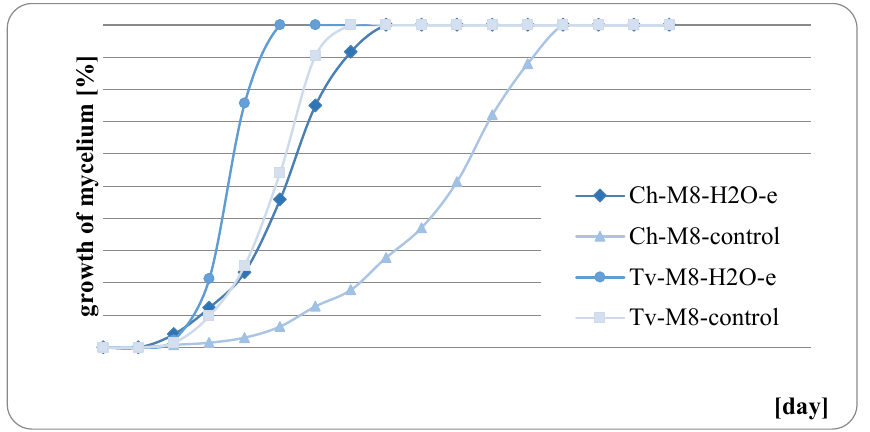
Figure 12. Growth of fungi on M. suaveolens ‘ Variegata ’ with and without extraction.